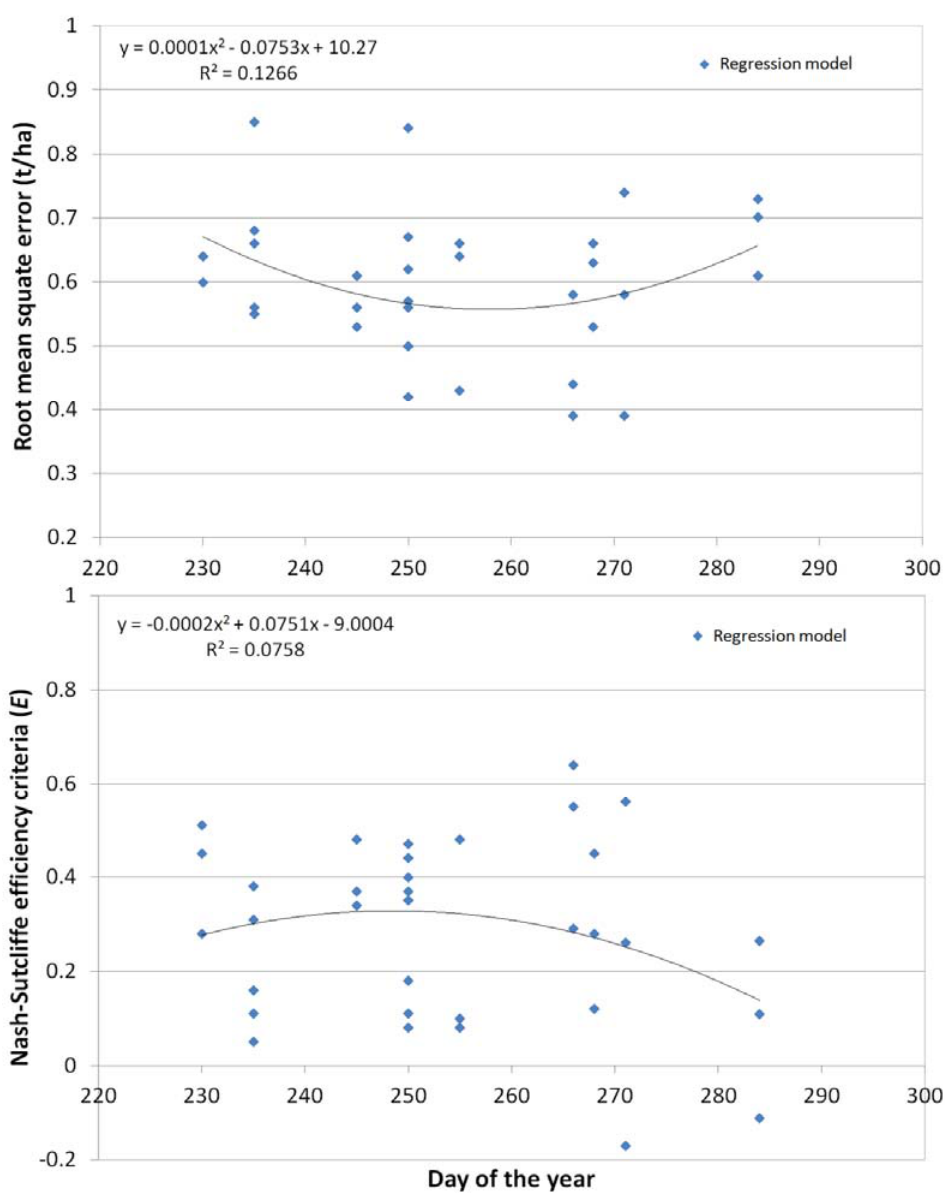
Figure 3. Root Mean Square Error (RMSE) and the Nash-Sutcliffe Efficiency Criteria ( E ) values by day of the year for the regression